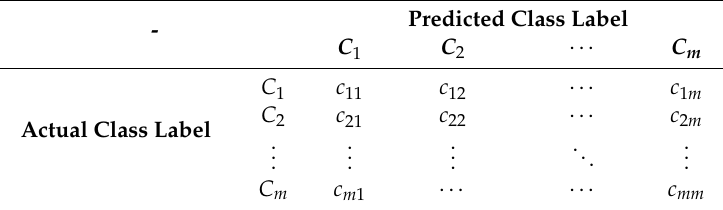
Table 3. Confusion matrix ( C )